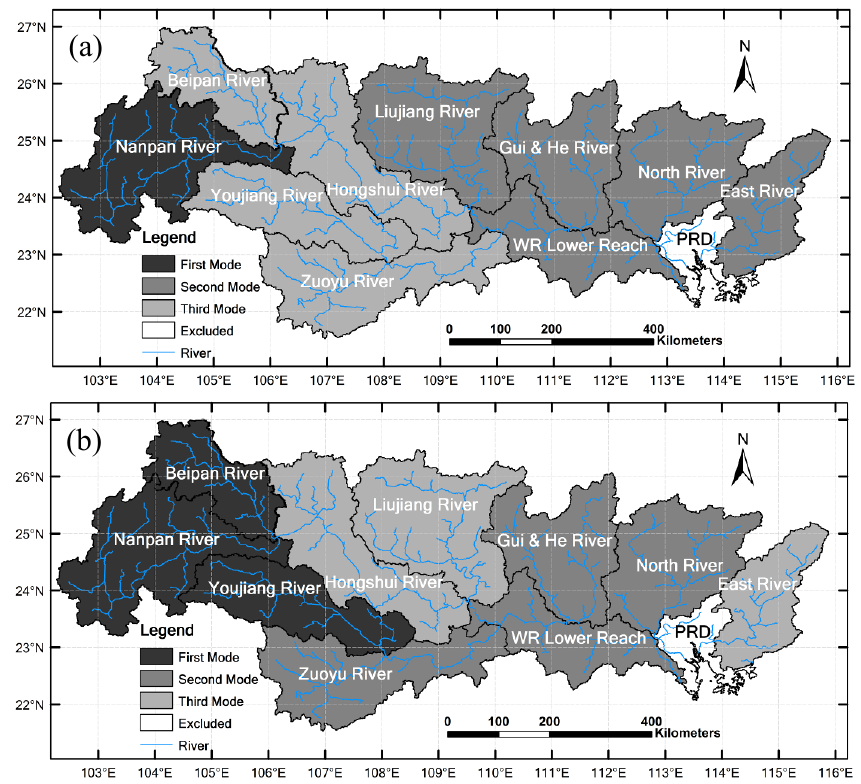
Fig. 4. (a) Spatial distribution of coherent modes (in Fig. 3) on global wavelet spectrum of runoff. (b) Same as (a) but for soil moisture.